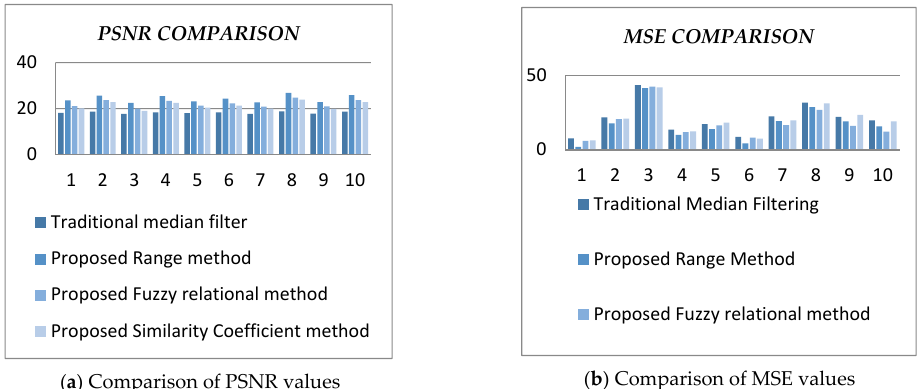
Figure 4. Comparative analysis of PSNR and MSE values. ( a ) Comparison of PSNR values ( b ) Comparison of MSE values. 4.1. Normalized Otsu’s Segmentation The output image given in Figure 5 was used to derive the feature vector from the different frequency levels using wavelet functions.